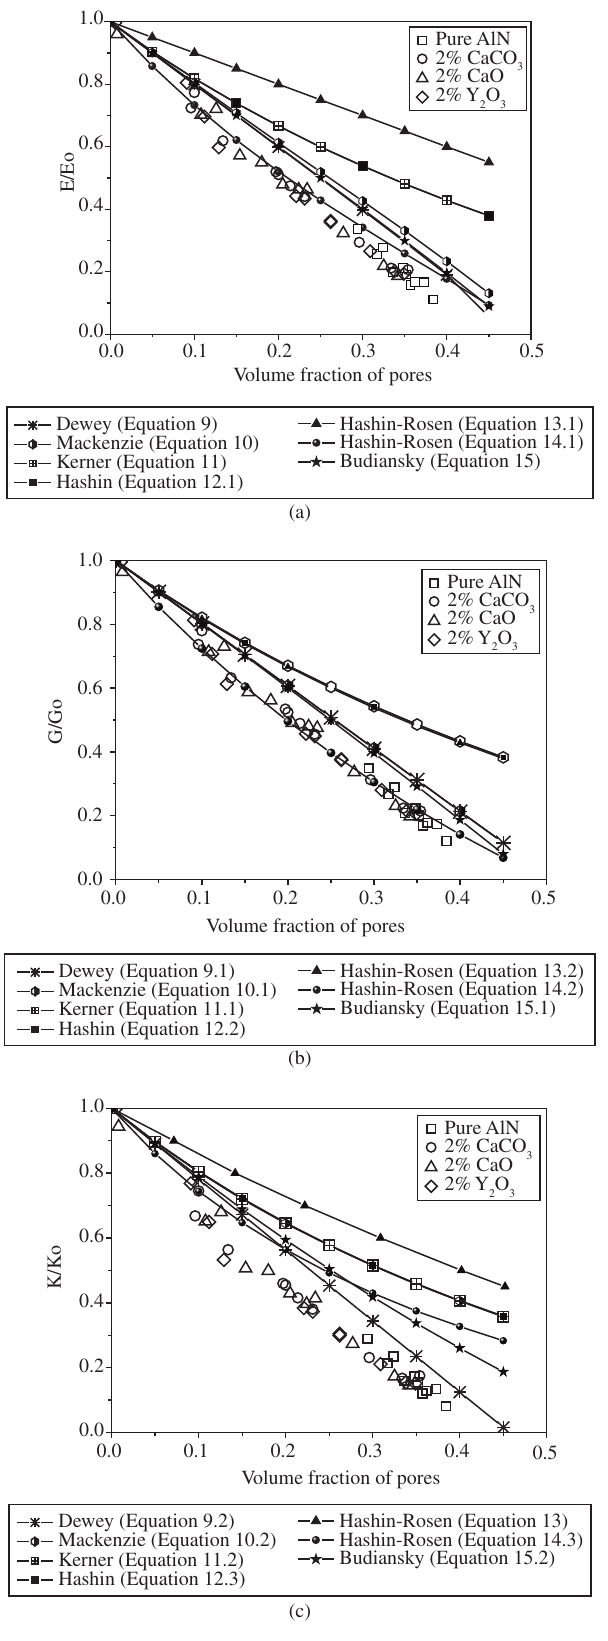
Figure 7. Relative elastic moduli vs. porosity: a) Young’s, b) shear, and c) bulk modulus. The curves show analytical models based on stress concentration (Table